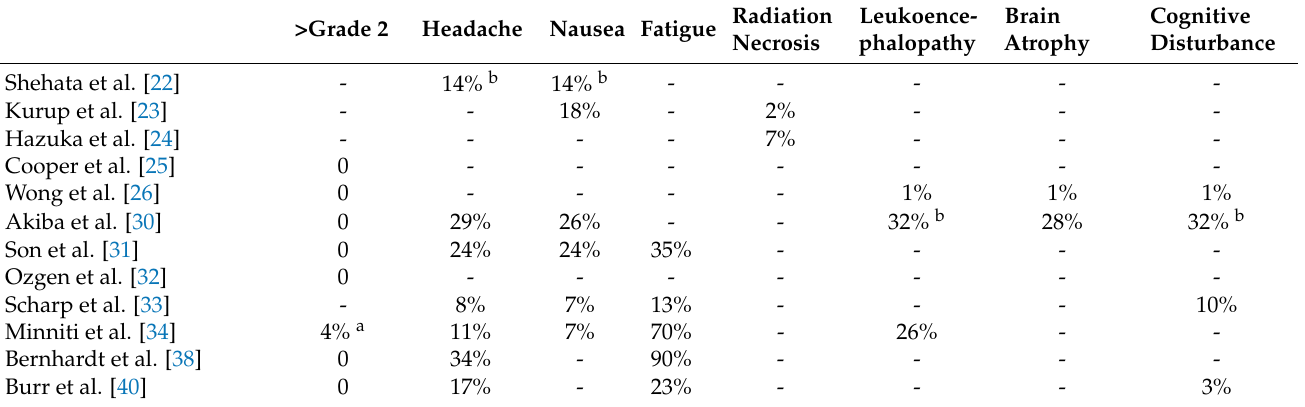
a : Grade 3 leukoencephalopathy. b : Occurrence rate was included 2 categories in 2